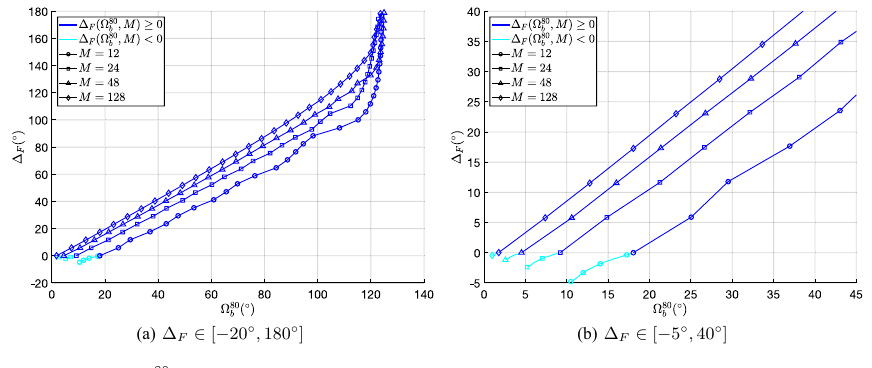
Fig. 5 (cid:31) F versus (cid:31) 80 b for M